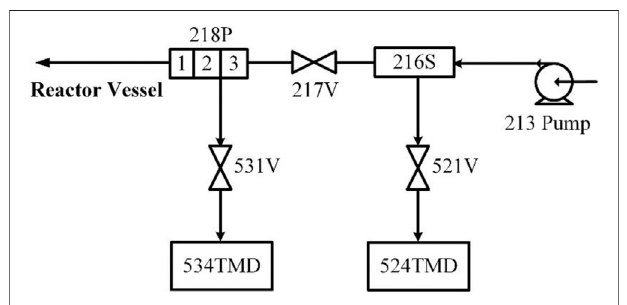
FIGURE 4 | Large break LOCA position.